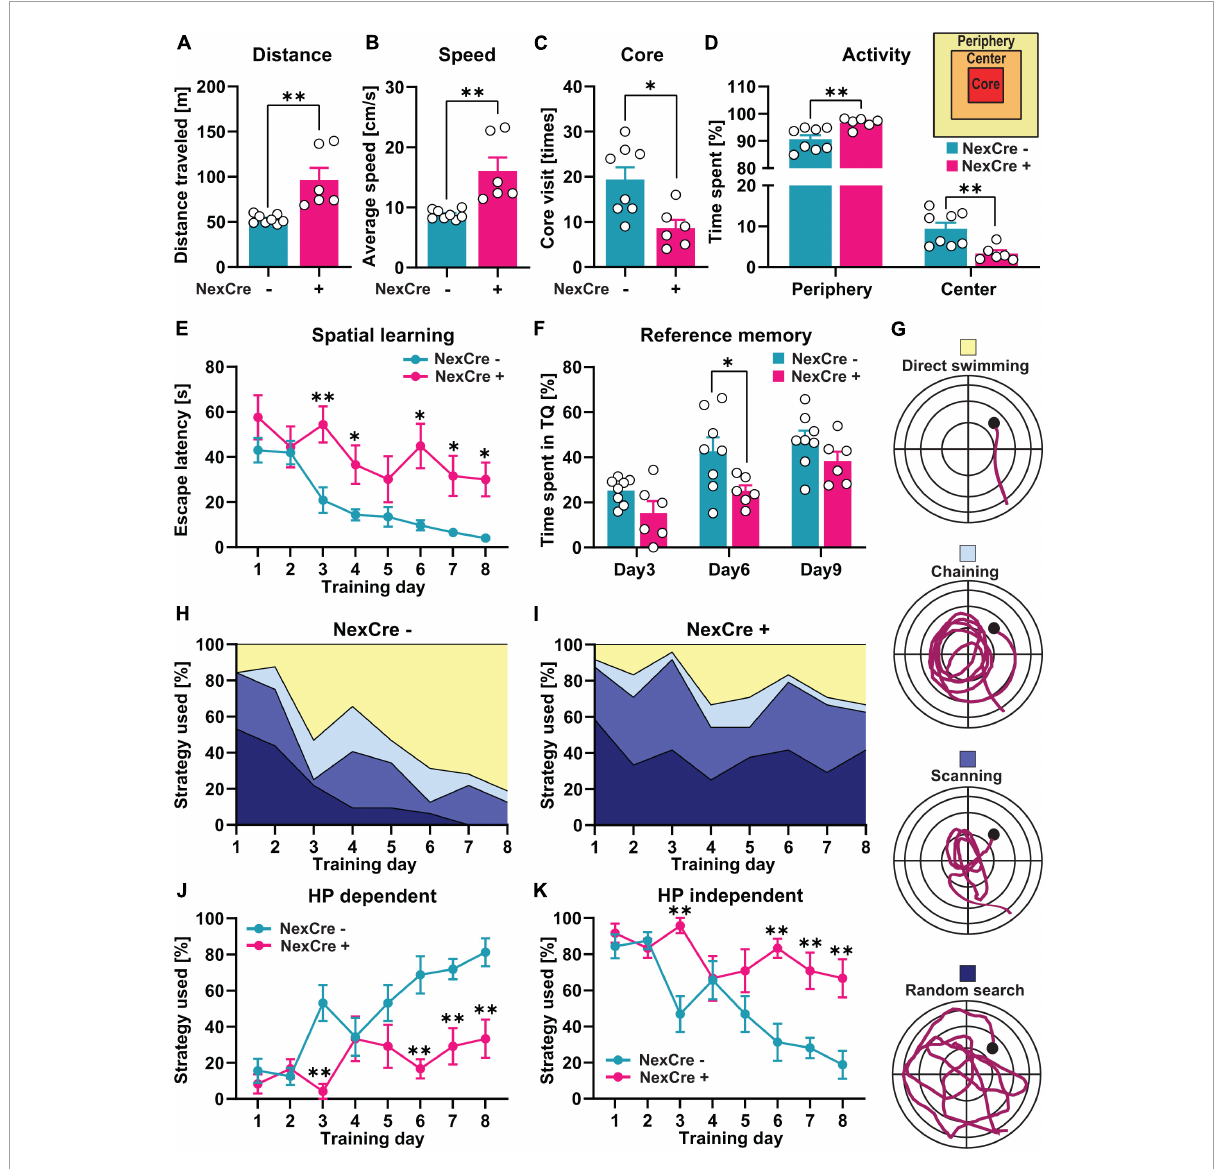
FIGURE2 Absence of TTL in the neocortex and hippocampus results in impaired cognitive function. (A–D) 4–5-month-old TTL lox / lox / NexCre + mice compared with control mice traveled a longer distance (A) , had a higher average speed (B) , a lower number of core visits (C) , and spent more time in the periphery and less time in the center zones of the open-field arena (D) . (E,F) In the Morris water test, increased escape latency (E) and lower percent time spent in the target quadrant (F) indicate impaired spatial learning and memory formation in the TTL lox / lox / NexCre + mice compared with the control mice. (G–K) Analysis of learning strategies used during water maze training (G) showed that the TTL lox / lox / NexCre + mice used a less hippocampus-dependent search strategy and more hippocampus-independent search strategies to find the hidden platform compared with the control mice during 8 days of learning (H–K) . Data are presented as mean ± SEM, ∗ p < 0.05 and ∗∗ p < 0.01, N = 6–8 in each group.